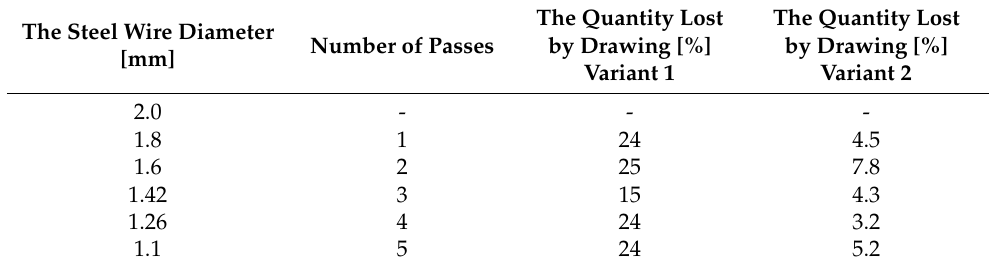
Table 2. Percentage values of the loss by drawing of the protective